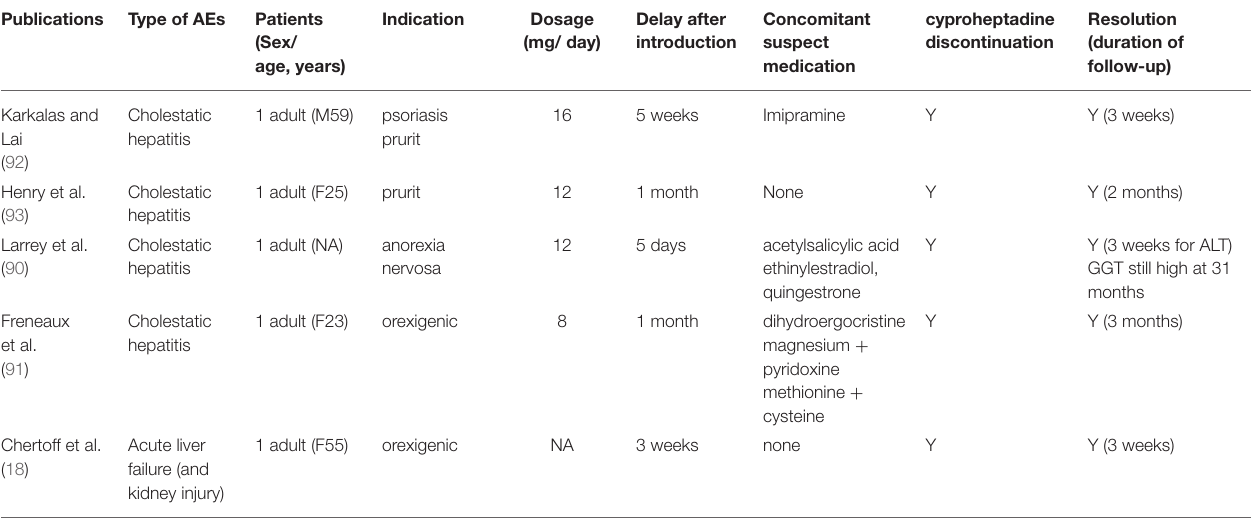
TABLE 5 | Case reports of hepatic adverse events (AEs) with cyproheptadine reported in